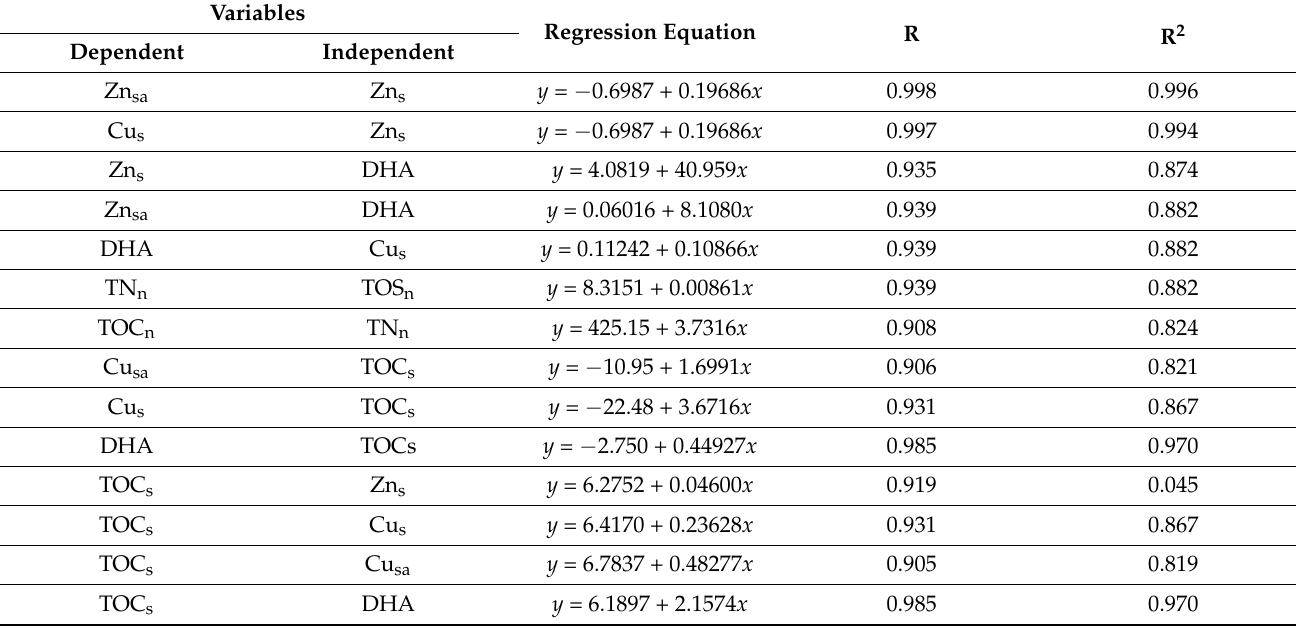
Figure 2. Configuration of variables in the system of the first two axes PC1 and PC2 of principal components. TOC s —total organic carbon in soil, SO 42 − —sulphate sulphur in soil, DHA—dehydrogenase activity, TS s —total S in soil, Cu s —total Cu in soil, Fe s —total Fe in soil, Mn s —total Mn in soil, Zn s —total Zn in soil, Cu sa —available Cu in soil, Fe sa —available Fe in soil, Mn sa —available Mn in soil, Zn sa —available Zn in soil, TN n —total N in pine needles, TOC n —total organic carbon in pine needles, TS n —total S in pine needles, Cu n —total Cu in pine needles, Fe n —total Fe in pine needl, Mn n —total Mn in pine needles, Zn n —total Zn in pine needles, Chl a+b—total chlorophyll content in pine needles, Carot—carotenoids in pine needles; A—Białe Błota, B—Belma Electomechanical Plant, C—Zachem Chemical Plant, D—The Zbigniew Załuski Park, E—The Forest Park of Culture and Recreation. Table 5. Correlation coefficient (R), determination (R 2 ) and linear regression models for selected properties of soils and pine needles ( n = 12; p <